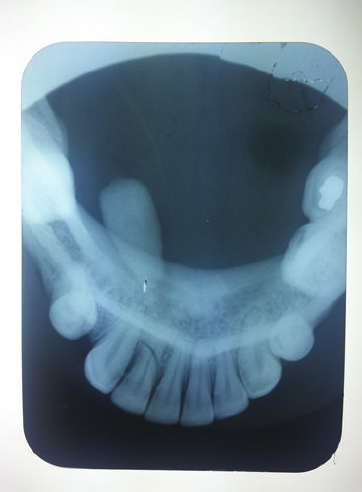
Figure 2: Occlusal